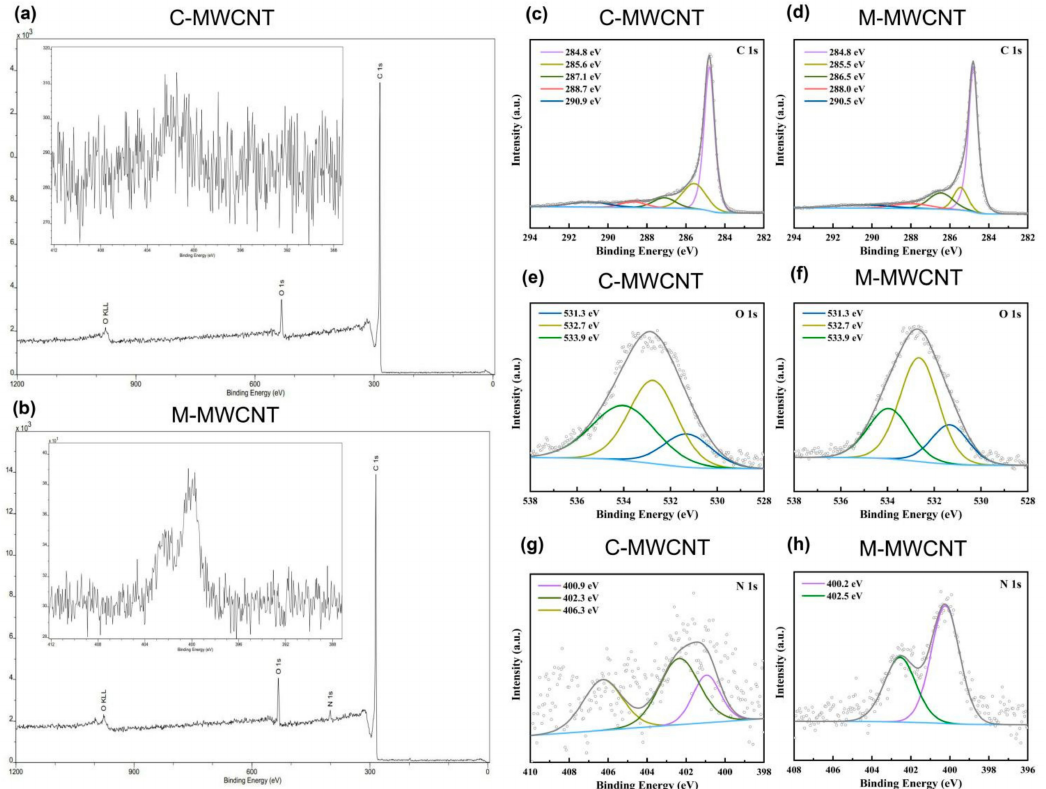
Figure 3. XPS analysis of the M-MWCNT and C-MWCNT: ( a , b ) XPS survey scan spectra of M- MWCNT and C-MWCNT. The inset is magnification of the N1s region in M-MWCNT and C-MWCNT spectrum. ( c , d ) Fitted XPS C1s spectra of M-MWCNT and C-MWCNT. ( e , f ) Fitted XPS O1s spectra of M-MWCNT and C-MWCNT. ( g , h ) Fitted XPS N1s spectra of M-MWCNT and